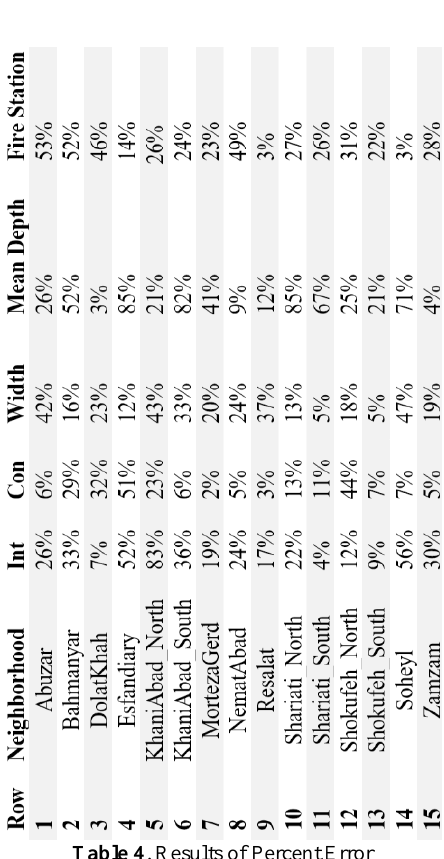
Table 3 . Results of Fuzzy Functions